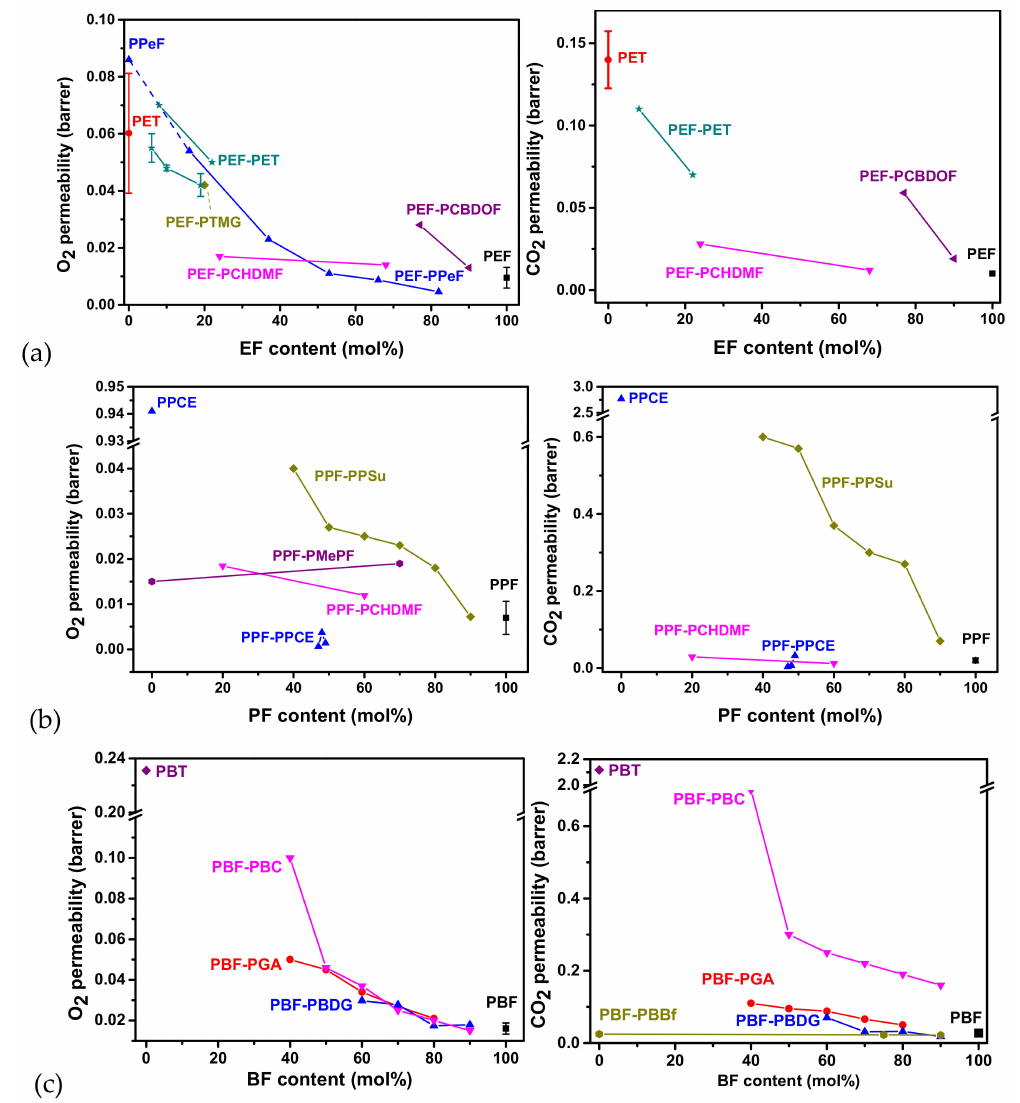
Figure 21. E ff ect of comonomer ratio on gas barrier properties of FDCA-based copolyesters ( a ) PEF, ( b ) PPF, and ( c ) PBF (data adopted from bibliography). Permeability of PBT values were obtained from